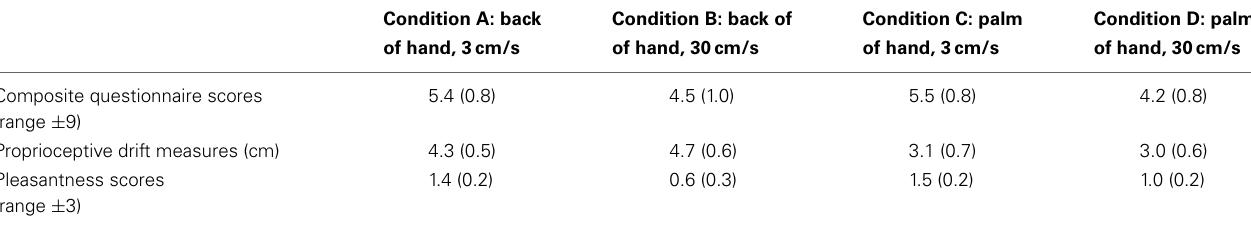
Table 2 | Mean scores ( ± 1 s.e.m) for all the composite of questionnaire items 1, 2, and 3, proprioceptive drift scores (post-stroking measure—baseline measure in cm) and pleasantness scores across all four conditions.